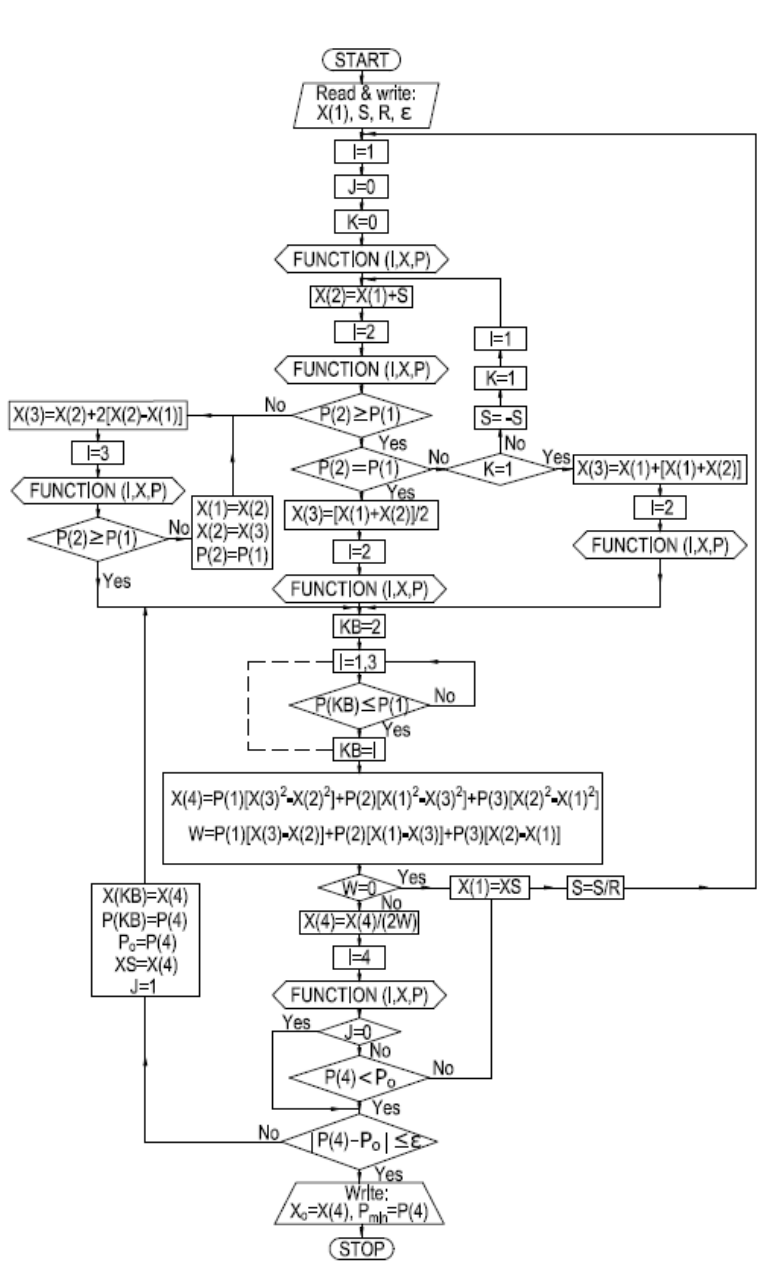
Figure 5. Flow chart of searching algorithm with an accelerated step.